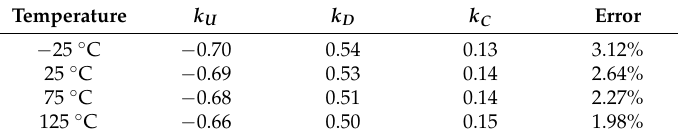
Table 2. Coefficients and errors at different